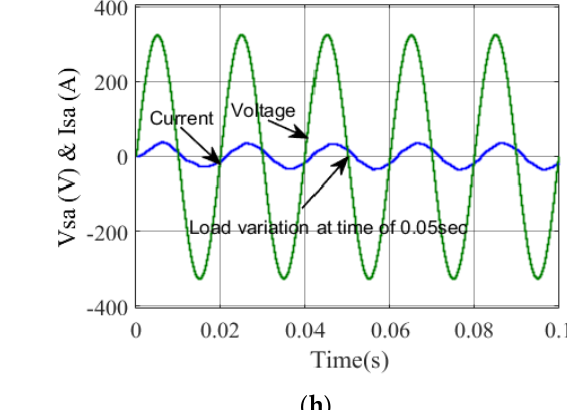
Figure 11. Simulated responses of three phase SSI-based SAPF connected at DRB RC load with HCC cum FLC: ( a ) Supply current, ( b ) load current, ( c ) compensation current, ( d ) THD, (e) V 2 DC link voltage, ( f ) V 1 DC link voltage, ( g ) SSI output voltage and ( h ) source voltage (V sa ) and source current (I sa ) of phase A.